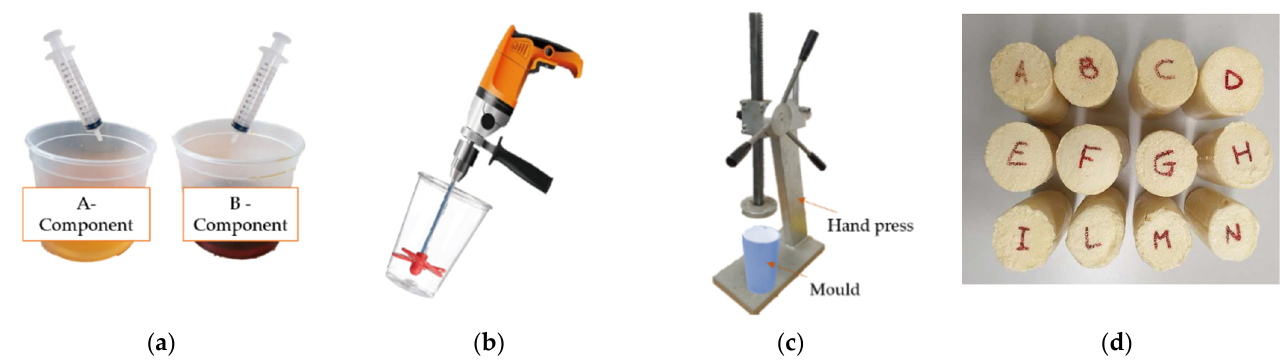
Figure 2. Sample preparation: ( a ) Sampling of the two components with syringes (Volume ratio 1:1), ( b ) injection of both components into a plastic cup being mixed through a propeller-equipped drill, ( c ) outpour of the mixed foam inside a mould, closed by a hand press, and ( d ) specimens for tests.